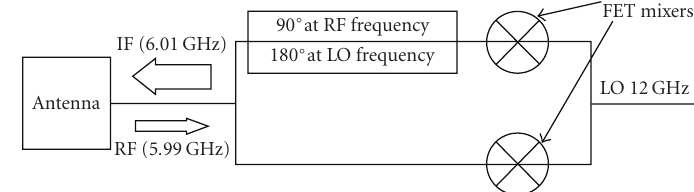
Figure 5: Schematic diagram of an active phase-conjugating element.